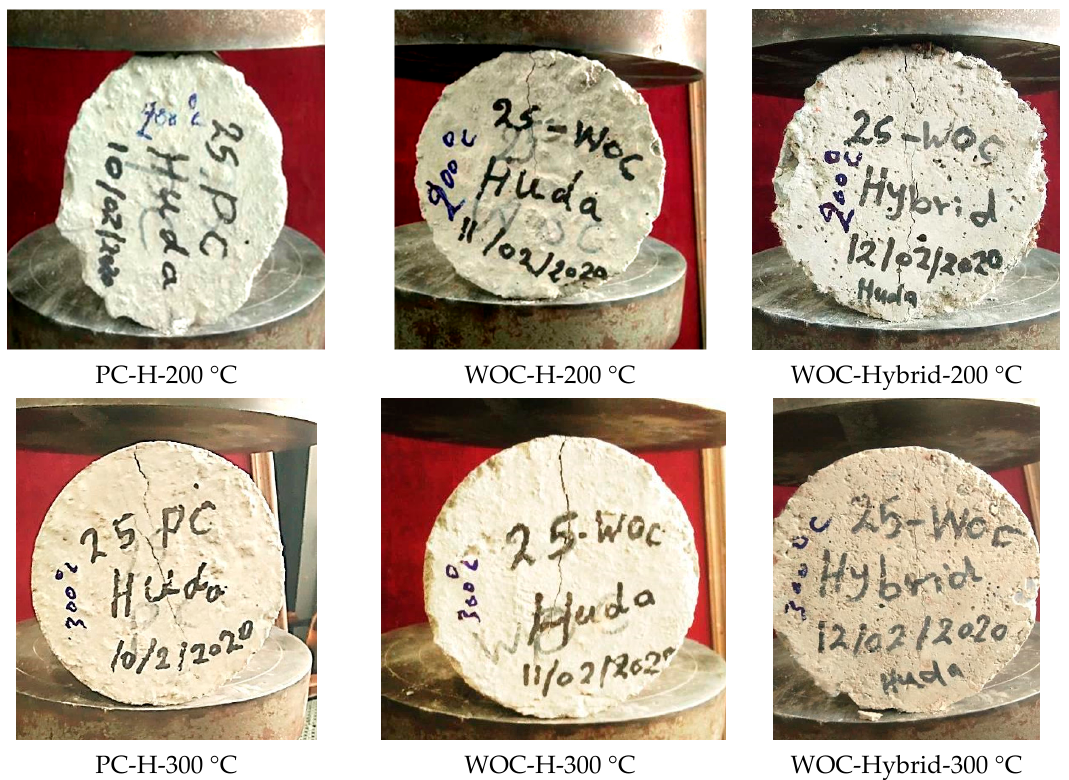
Figure 11. PC, WOC, and WOC-Hybrid cylinder under tensile strength machine at failure after exposure to elevated temperatures of 100 °C, 200 °C, and 300 °C.